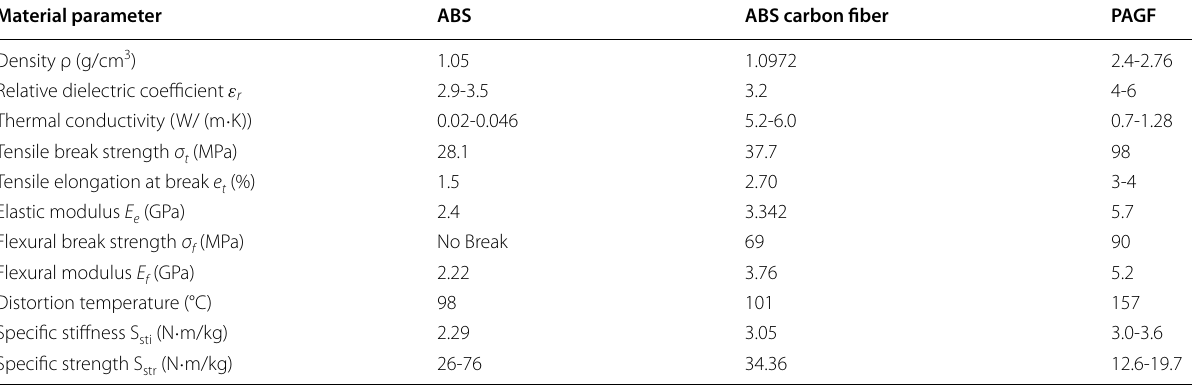
Table 3 Polymer materials and mixed materials of carbon fiber and GF Material parameter